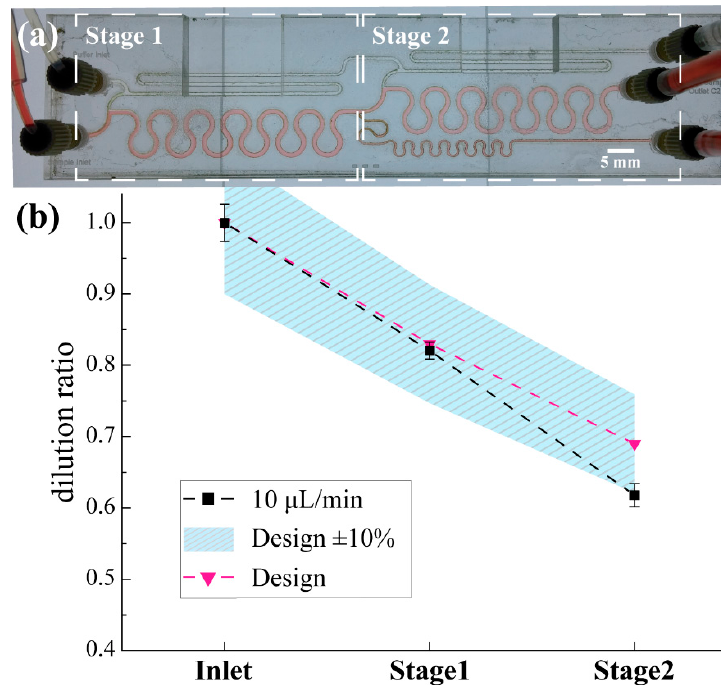
Figure 7. Dilution ratio validation of the two-stage PMMA prototype using commercial Accu-Check ® glucose meter. MFS 430 µ m ( a ) The prototyped two-stage PMMA diluter during performance validation experiment. Channel height is 275 µ m ( b ) The solid marks represent the dilution performance under 10 µ L/min flow rate.